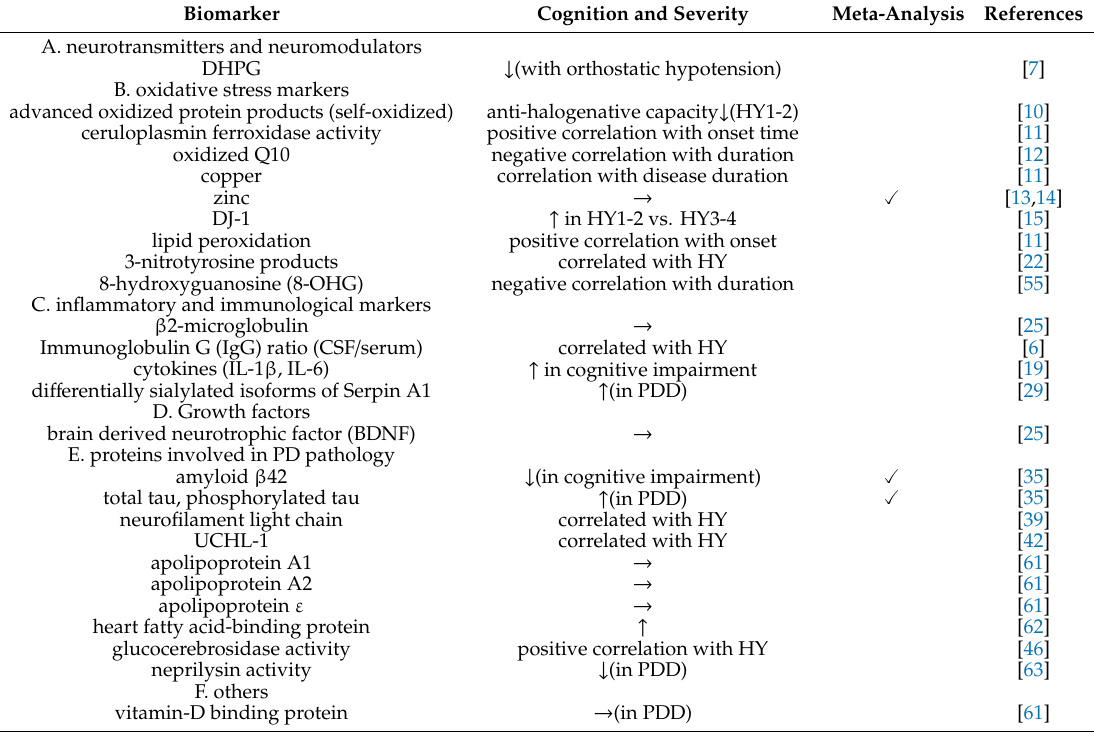
Table 3. Candidate cerebrospinal fluid biomarkers for representing disease severity or cognitive